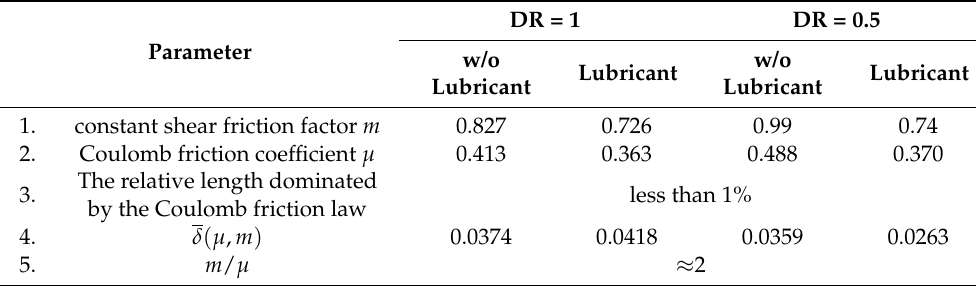
Table 3. Analysis of the experimental data and evaluation of friction coefficients by means of the developed